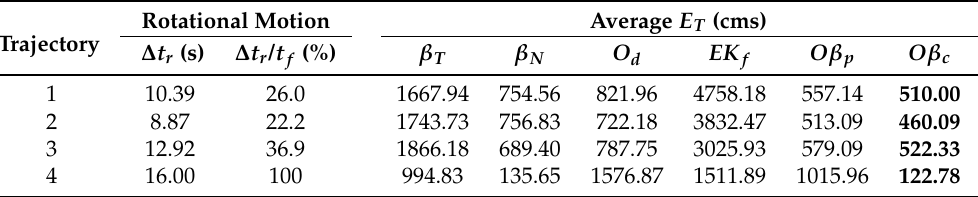
Table 7. Summary of average localization errors for Trajectories